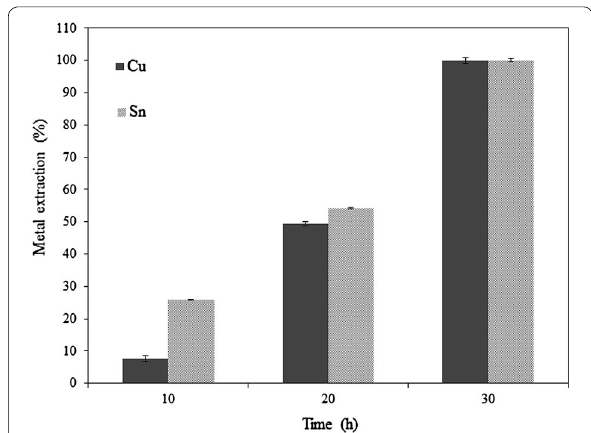
Fig. 1 Time period evaluation of metal recovery from Sn–Cu solder (100 mg) by 10 ml acetic acid (100%) at 150 rpm shaking speed and at 30 °C